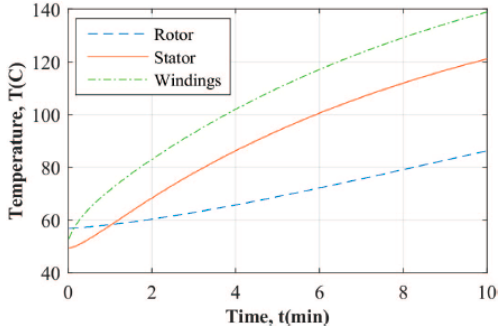
Figure 1. Rise in temperature under instantaneous load scenario [13].